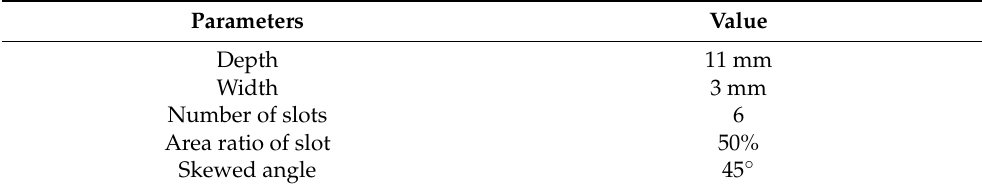
Table 1. Basic parameters of axial skewed